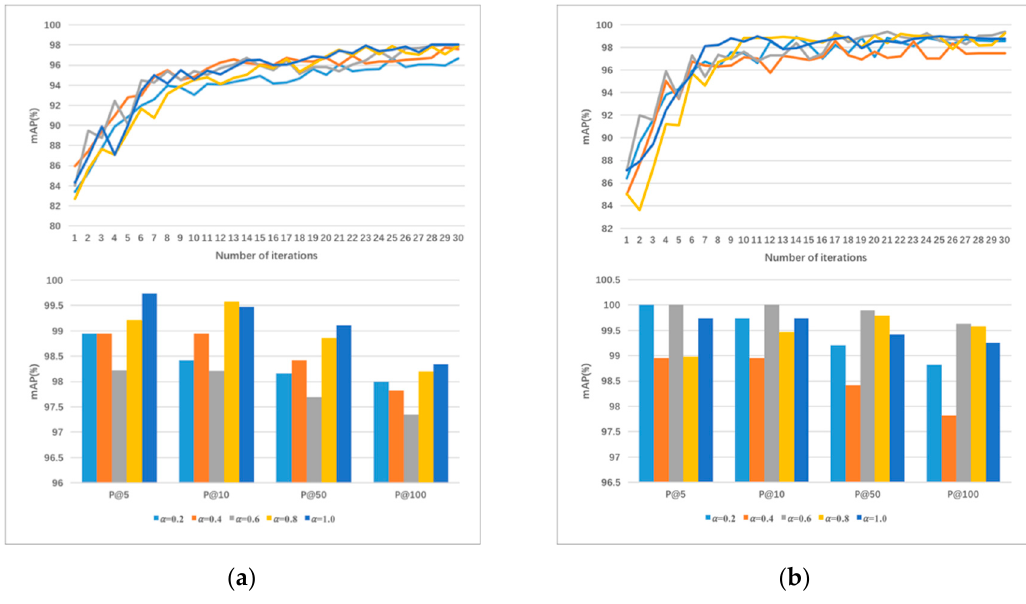
Figure 8. The impact of the di ff erent threshold α . Evaluation is performed with VGG16 ( a ) and ResNet50 ( b ) on PatternNet datasets. The curve represents the evolution of mAP in the training iteration. The histogram shows the evaluation of P@K under di ff erent thresholds α .